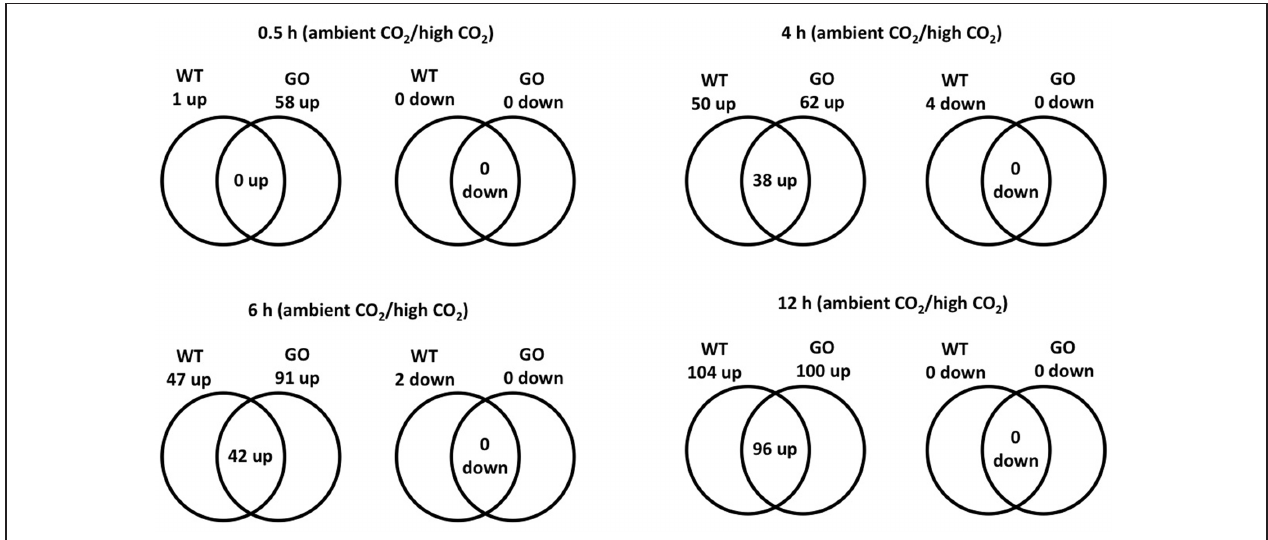
FIGURE 1 | Venn diagram of the number of ROS-responsive genes differentially expressed in wild-type and GO plants at different time points (0.5, 4, 6, and 12h) after the transfer of plants grown at high CO 2 concentration (3000ppm) to ambient CO 2 concentration (380ppm).